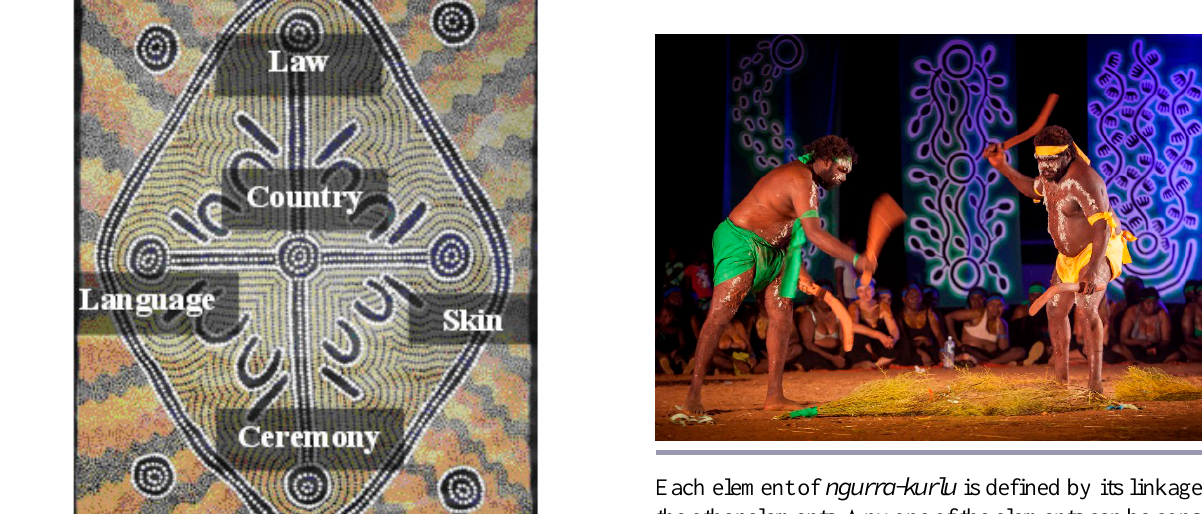
Fig. 3. Dancers performing the ngapa -rain ceremony at the Milpirri cultural event at Lajamanu in 2012. The image illustrates ngurra-kurlu relationships to the ngapa (rain) narrative. The two men are the two hunters depicted in the story. Skin is represented through the color coding of performance clothes and banners, law through the banners in the background of the stage, and country through the ceremonial plant on the